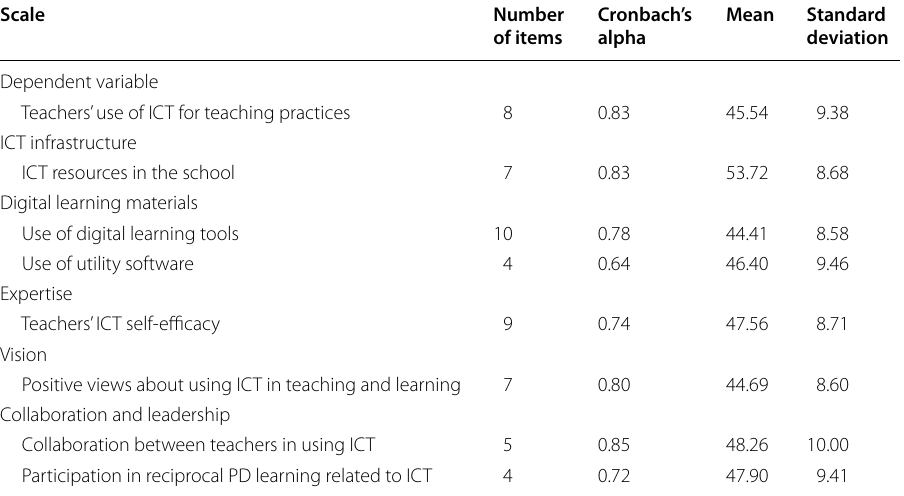
N 420 teachers; alternative weighting approach; the scales were built by ICILS as IRT WLE scores (Fraillon et al., 2020a) with = M 50, STD = =